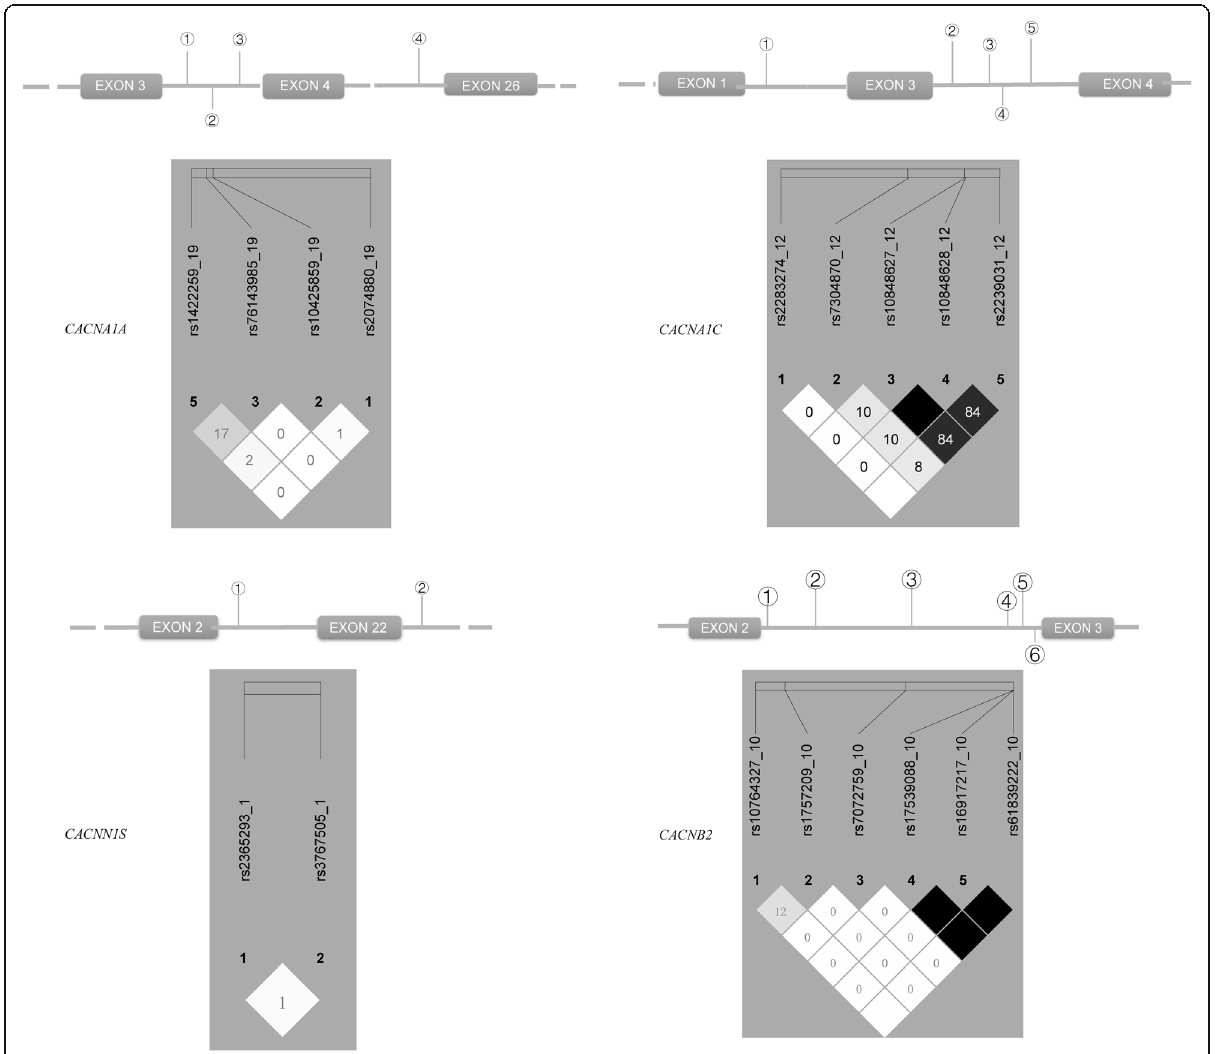
Fig. 1 Locations of the 17 SNPs at the VDCC coding-gene locus and their haplotype configurations. The values shown in these haploblock figures are all r2 in Dai